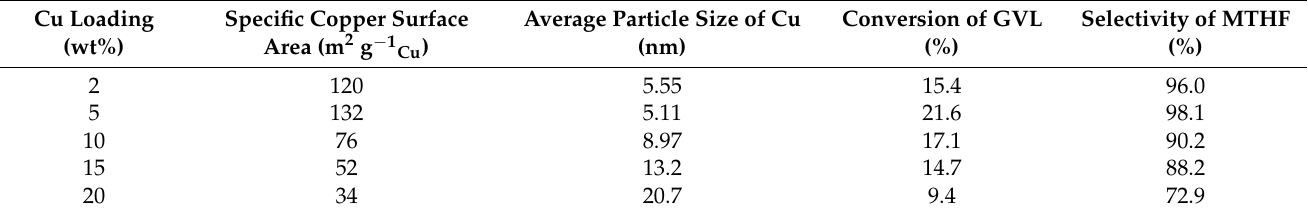
Table 6. Comparison between catalytic activity with catalyst properties in different Cu/SiO 2 catalysts.